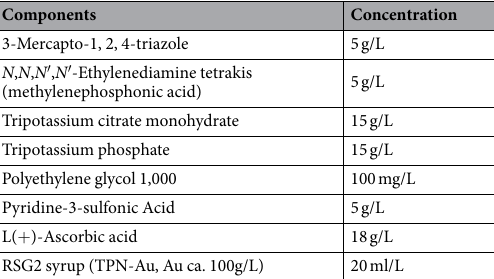
Components Concentration